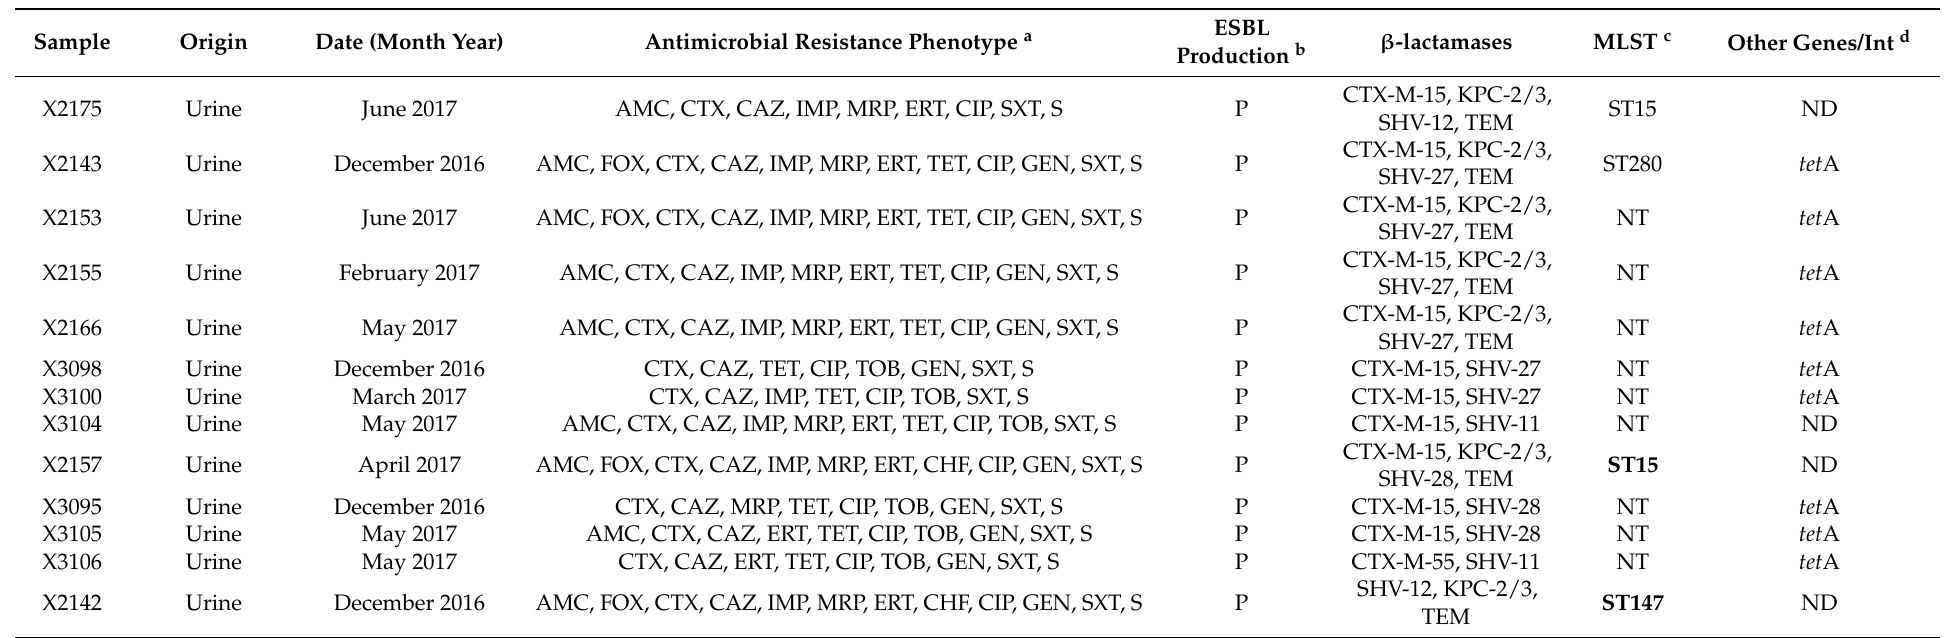
Table 2. Resistance phenotype and genotype present in the 24 CTX/CAZ R Klebsiella pneumoniae isolates from clinical samples in a Portuguese